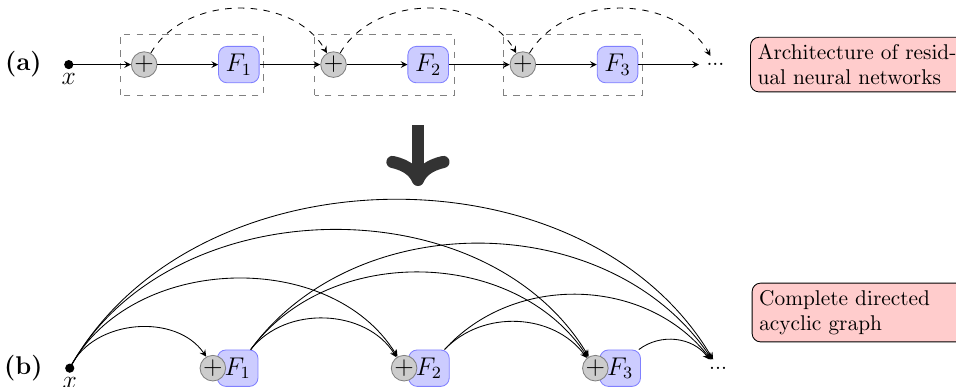
Figure 1. Example of mapping from residual neural networks to directed acyclic graphs (DAGs). ( a ) An example of the architecture of residual neural networks. The F i nodes represent non-linear transformations among data; the circles with plus signs inside represent summation of all ingoing data. ( b ) The complete directed acyclic graph mapped from the residual neural network. The nodes are compositions of summation and non-linear transformations; the lines represent data flows among